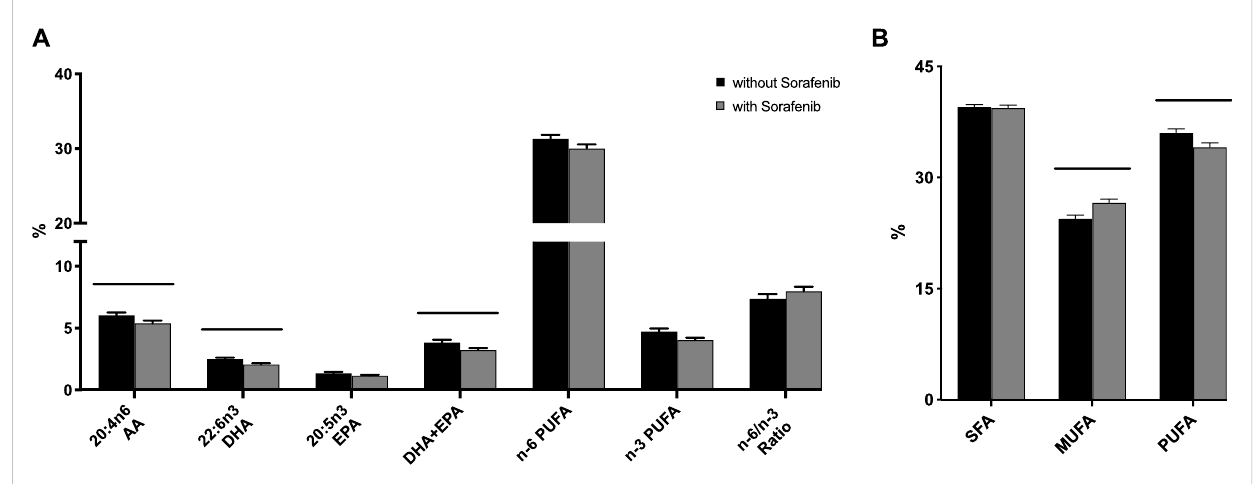
FIGURE 3 (A) Relativen-3(docosahexaenoicacid,DHA;eicosapentaenoicacid,EPA)andn-6(arachidonicacid,AA)PUFAlevelsinplasmafrom n =43patients with hepatocellular carcinoma (HCC) without and during sorafenib treatment individually, summarized and as a ratio. (B) Relative content of saturated fatty acids (SFA), monounsaturated fatty acids (MUFA) and polyunsaturated fatty acids (PUFA) in plasma from n = 43 patients with HCC without